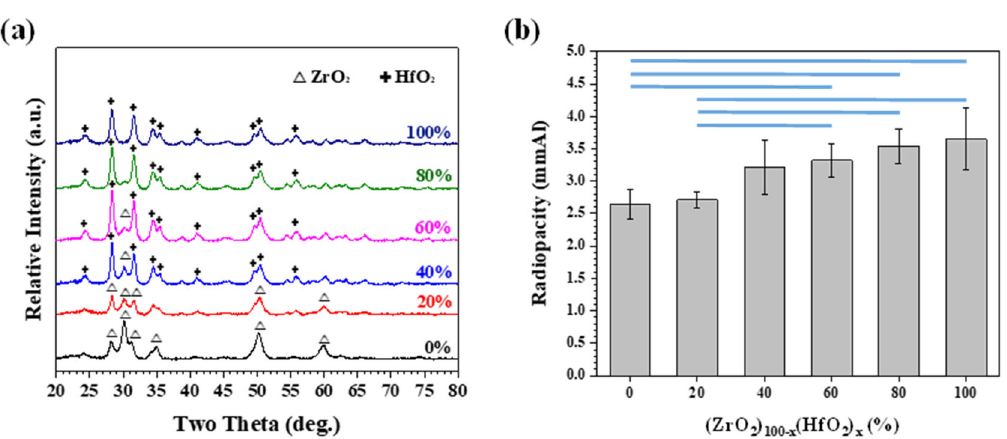
Figure 4. ( a ) X-ray diffraction patterns of as-milled (ZrO 2 ) 100-x (HfO 2 ) x powder and ( b ) corresponding radiopacities of as-prepared MTA-like cements. The horizontal blue lines indicated that the paired results were statistically different at a confidence level of 95%.